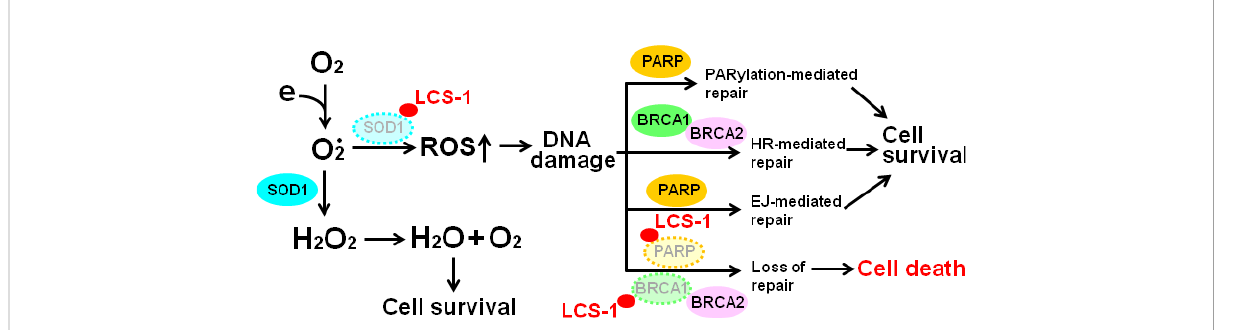
FIGURE 10 Model of the mechanism by which LCS-1 induces cell death. LCS-1 inhibited the enzyme activity of SOD1, resulting in the accumulation of ROS, leading to the induction of DNA damage. Meanwhile, LCS-1 induces the degradation of PARP. The dysfunction of PARP inhibits DNA damage repair via blocking both PARylation-mediated and EJ-mediated pathways. Furthermore, LCS-1 induces the degradation of BRCA1, eliciting the block of HR-mediated pathway. The inhibition of these three repair pathways results in death of glioma